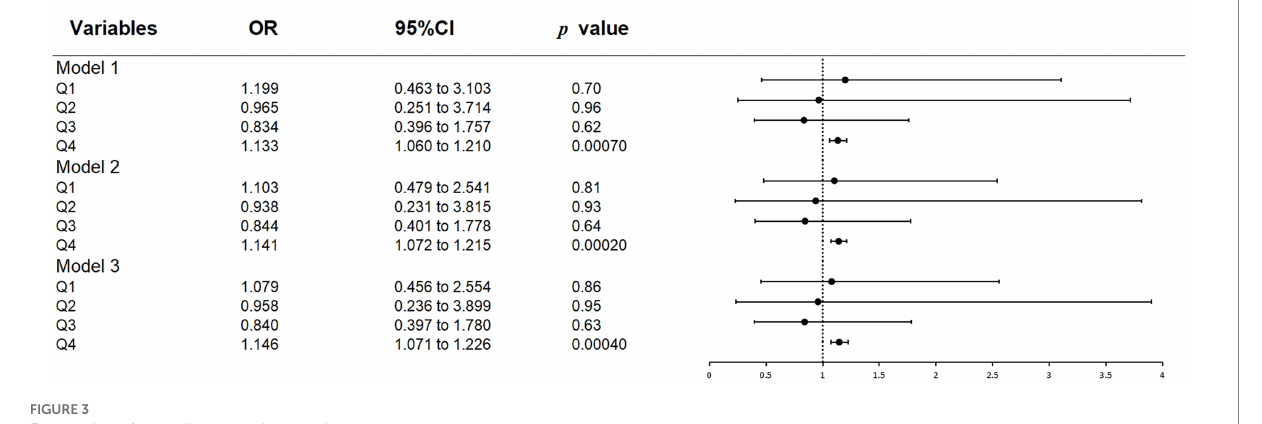
FIGURE 3 Forest plot of quantile regression